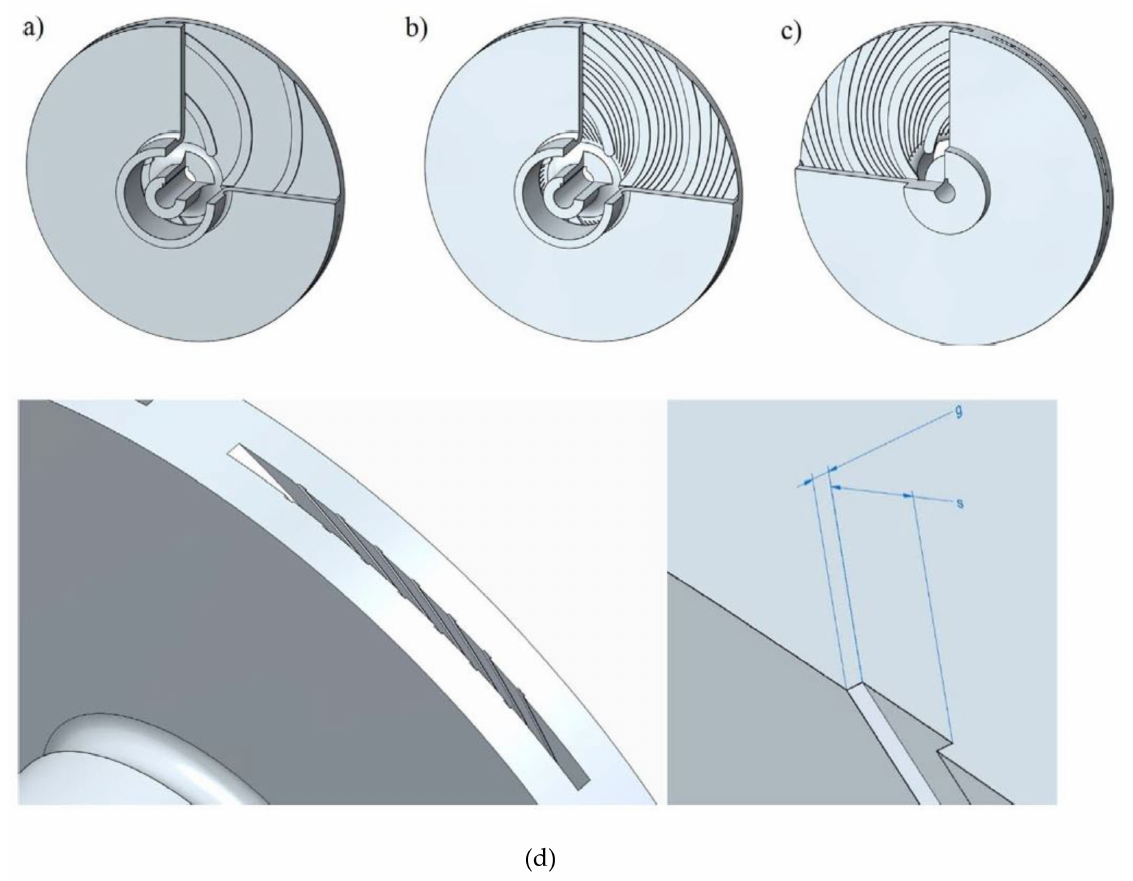
Figure 18. Smooth and micro-grooved impellers comparison: ( a ) smooth impeller, ( b , c ) micro-grooved impeller, ( d ) grooves together with characteristic dimensions